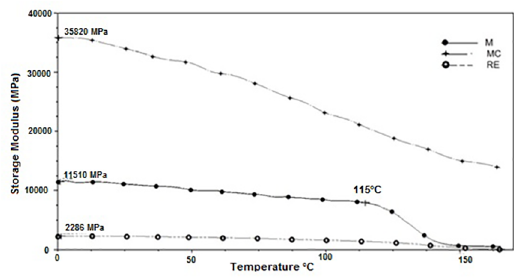
Figure 1. Mechanical test dynamic.